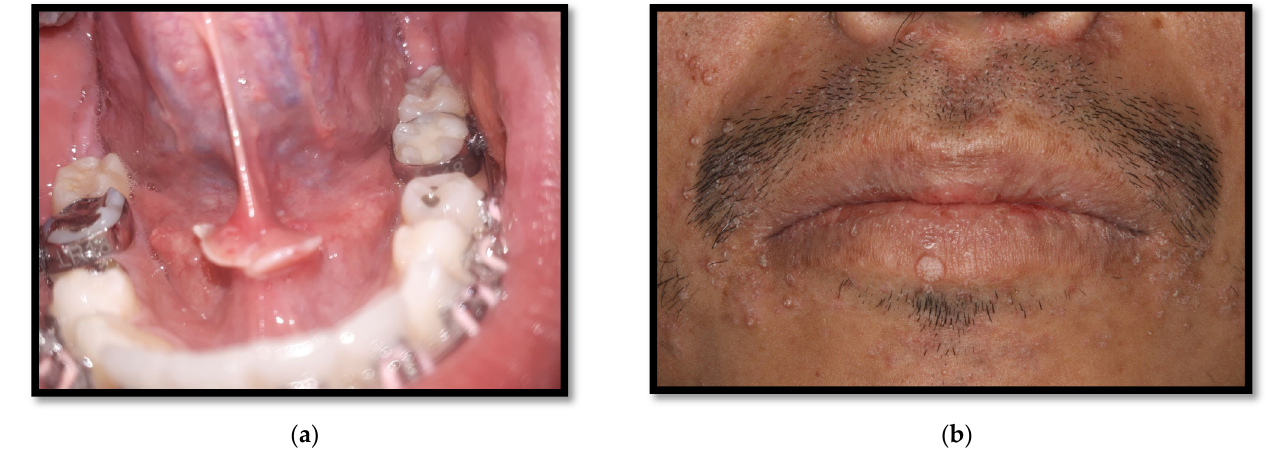
Figure 14. ( a ) Hyperplastic HPV lesion in the mucosa of the base of the lingual frenulum and sublingual caruncle; ( b ) wart due to HPV on the lower lip, with multiple umbilicated papules due to molluscum contagiosum and oily scaling lesions due to perioral seborrheic dermatitis. 11.